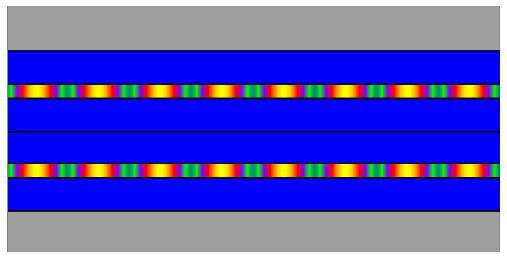
Figure 4. Side view ( X-Z plane) of the FBG-OADM in the numerical simulation.